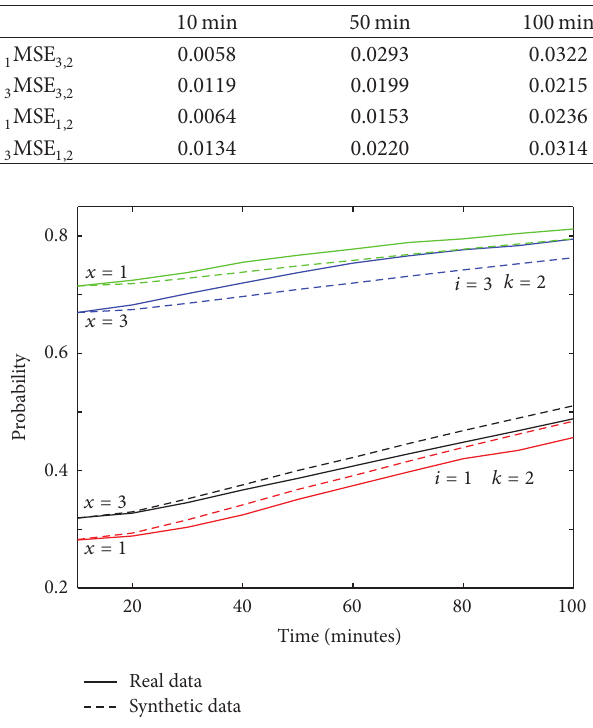
F 4: Comparison of maintainability functions for real and simulated